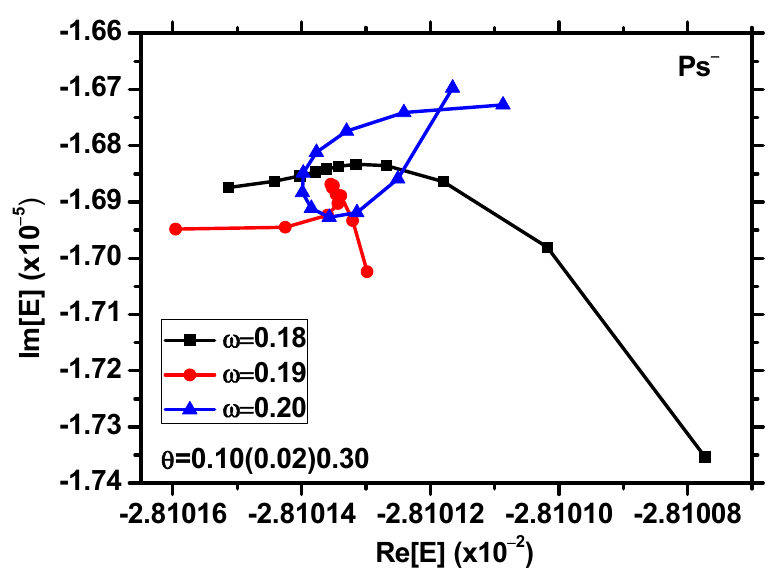
Figure 3. The rotational paths near the pole for the 1 P° (4) FR of Ps − lying below the Ps ( N = 3 ) threshold in the EP for three different values of the scaling parameter ω using 900-term ECW.